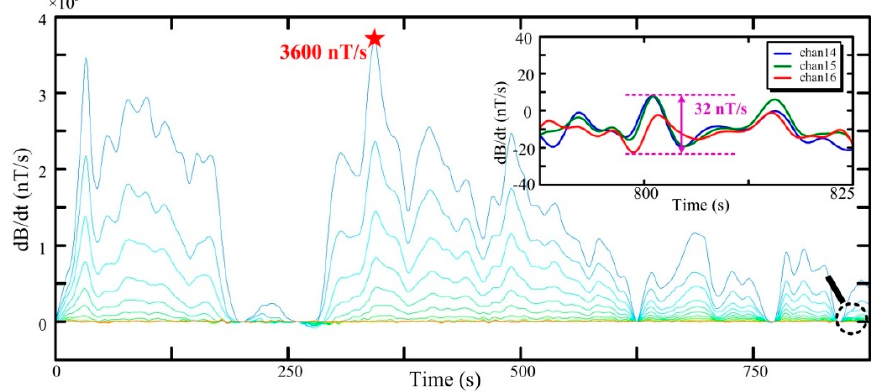
Figure 17. Normalization result of the received data with air-core coil B.